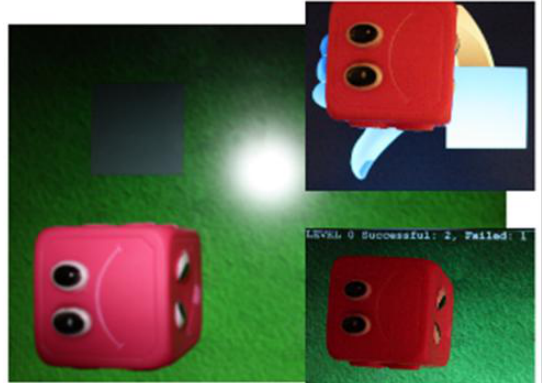
Figure 9. Game using real cubes on a virtual board